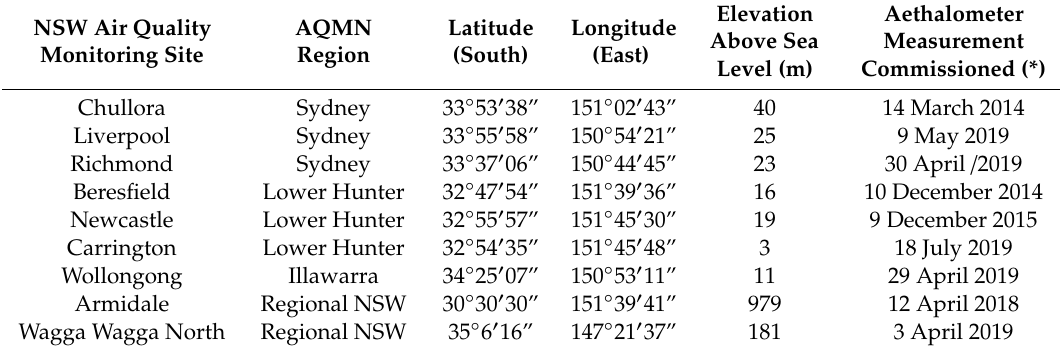
Figure 1. Air quality monitoring stations in NSW ( left ) and in the Greater Metropolitan Region of Sydney (GMR) with aethalometers installed ( right ). Table 1. NSW DPIE air quality monitoring stations with aethalometer installed.